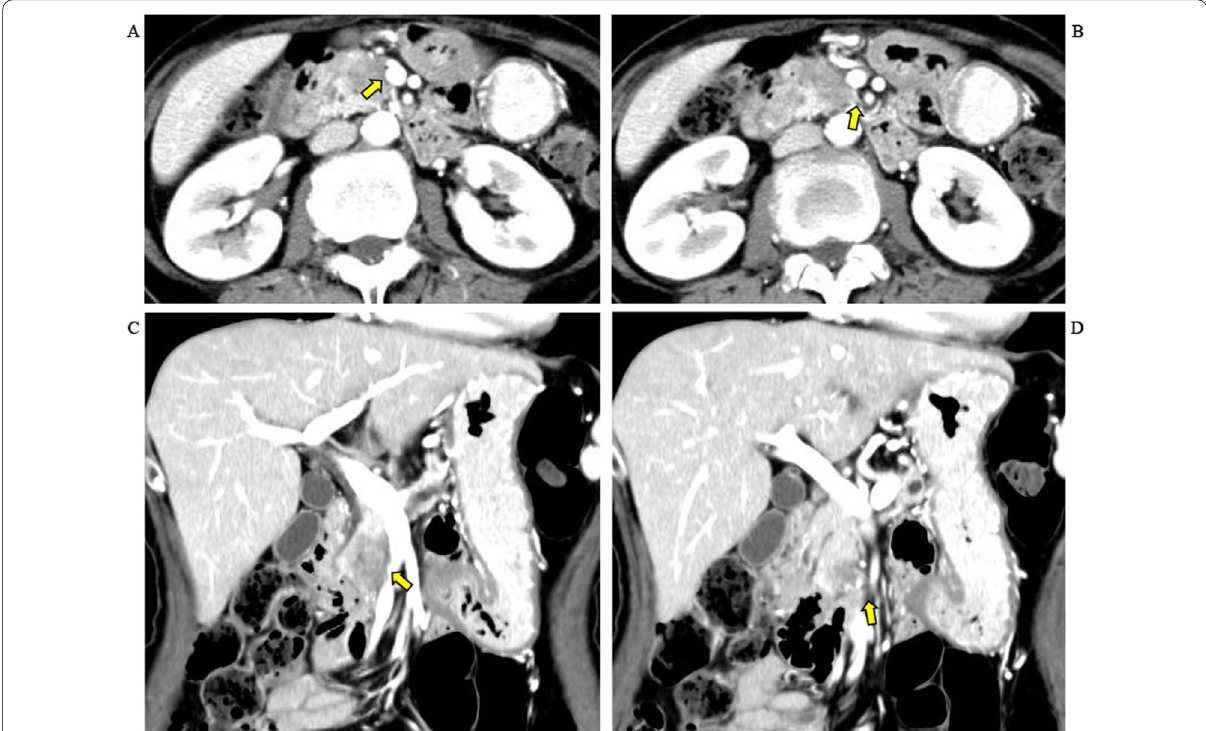
Fig. 1 Computed tomographic findings concerning the pancreatic tumor. The pancreatic tumor is in contact with the right side of the superior mesenteric vein (SMV) at the level of confluence of the first jejunal vein tributary, involving less than 180 degrees of the vein’s circumference ( A ). Longitudinal extent of the tumor along the SMV is about 20 mm ( C ). The tumor also has spread along the retropancreatic nerve plexus to a point near the superior mesenteric artery ( B , D